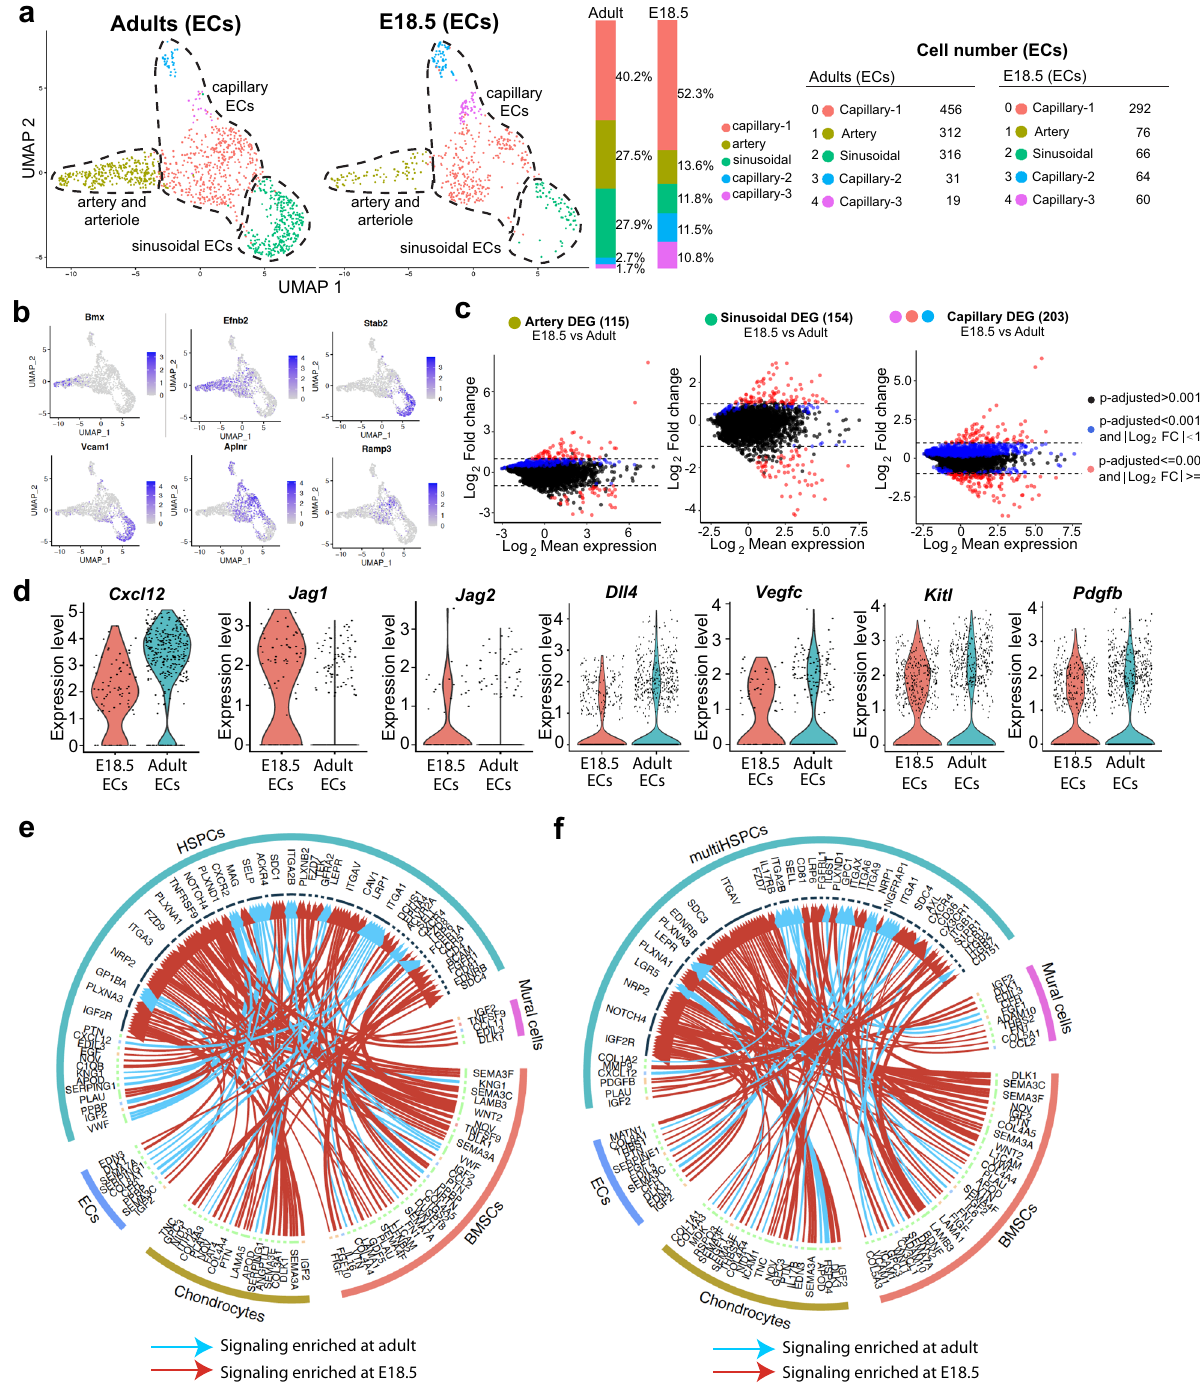
Fig. 3 Comparative analysis of embryonic and adult endothelial cells. a UMAP plot showing unsupervised subclustering of E18.5 and adult femoral ECs. Bar charts indicate percentage of each subcluster. Cell numbers are shown on the right. b UMAP plots showing distribution of representative markers for each EC subcluster. Color represents relative gene expression level. c DEGs for E18.5 and adult EC subclusters. Blue dots, p -adjusted value < 0.001; Red dots, p -adjusted value < 0.001 and Log 2 fold change >1. Two-tailed Student ’ s t test. d Violin plots showing expression of selected EC-derived HSPC- supporting factors at E18.5 or in adult with log normalized values ( y axis). e , f Interactome analysis of potential interactions (arrows) between non- haematopoietic supportive cells and HSPCs ( e ) or multipotent HSPCs ( f ). Width of line and arrow represent relative log2 fold change of genes. Cyan arrows indicate signaling enriched in adult; red arrows show enrichment at